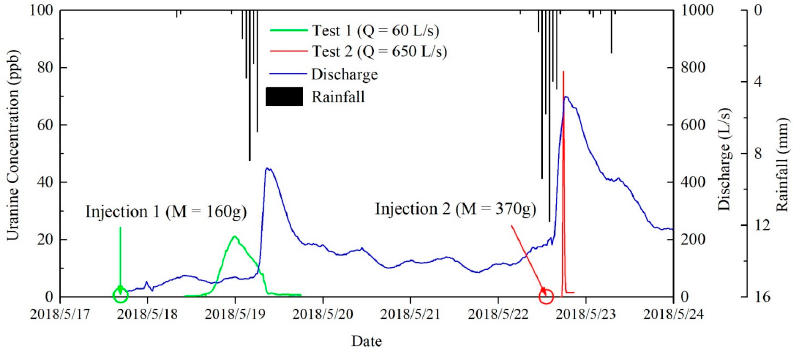
Figure 2. Breakthrough curves of tracer tests.